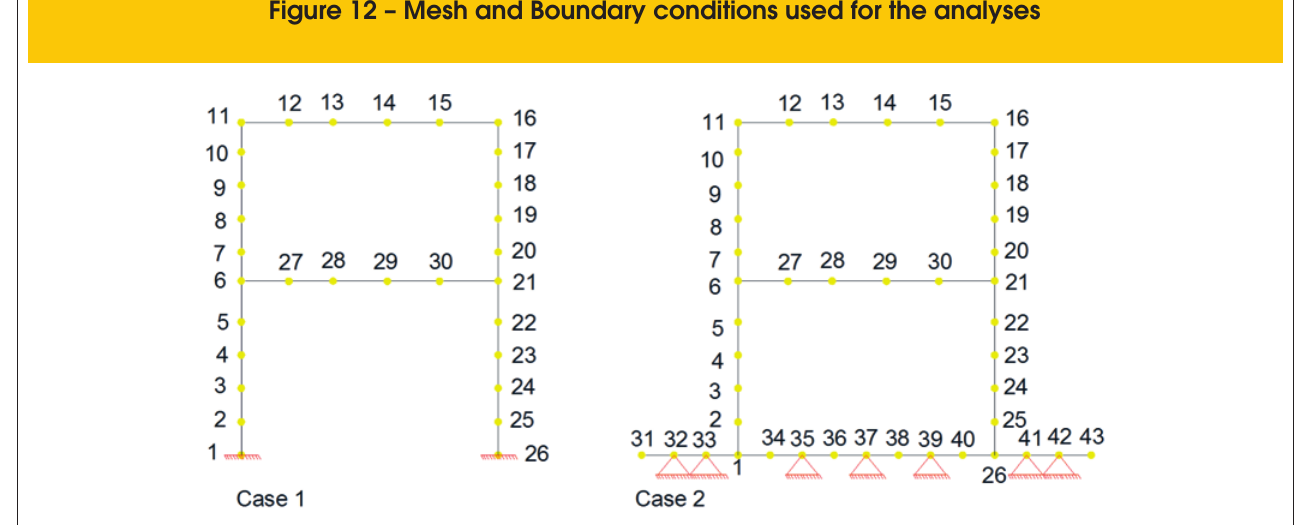
Figure 12 – Mesh and Boundary conditions used for the